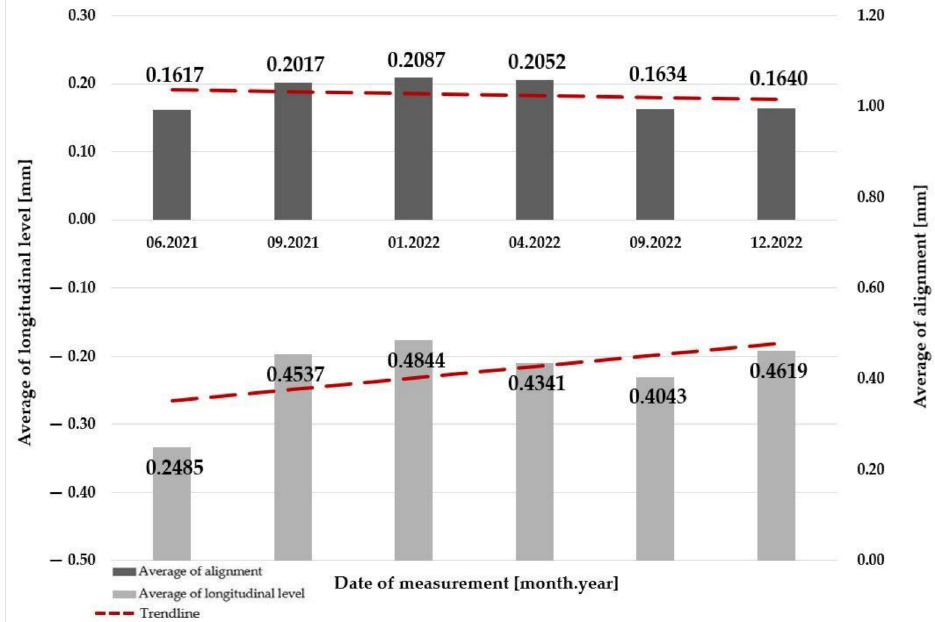
Figure 17. The change of average values of longitudinal level and alignment in Section